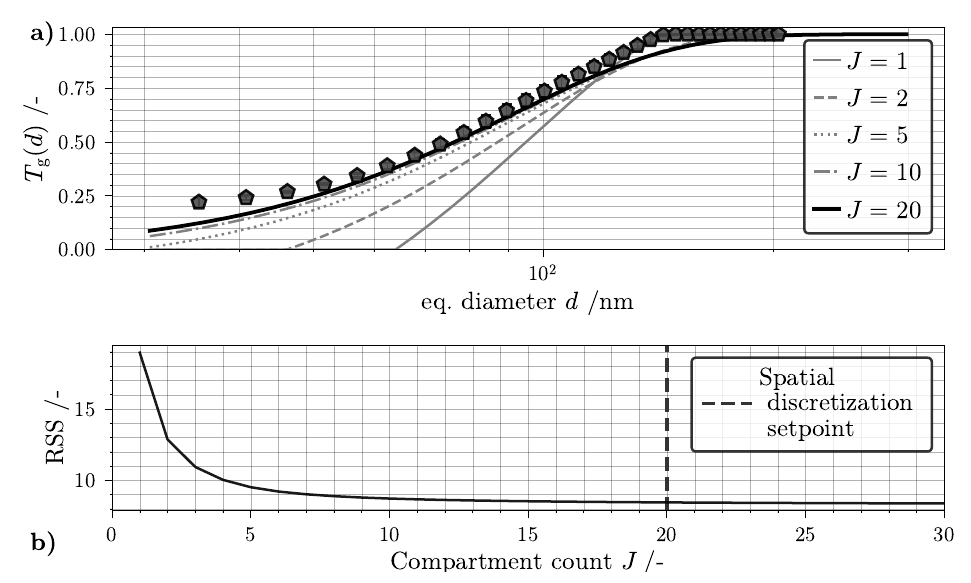
Figure A1. ( a ) Global grade efficiency for the RPS classification with boundary conditions listed in Table 1; markers show the ADC reference measurement and solid lines show the 1D-TCM output for different spatial discretization settings; ( b ) RSS calculated with Equation (A1) for different spatial discretization settings; the dashed line indicates the setpoint used for all simulations shown in the main